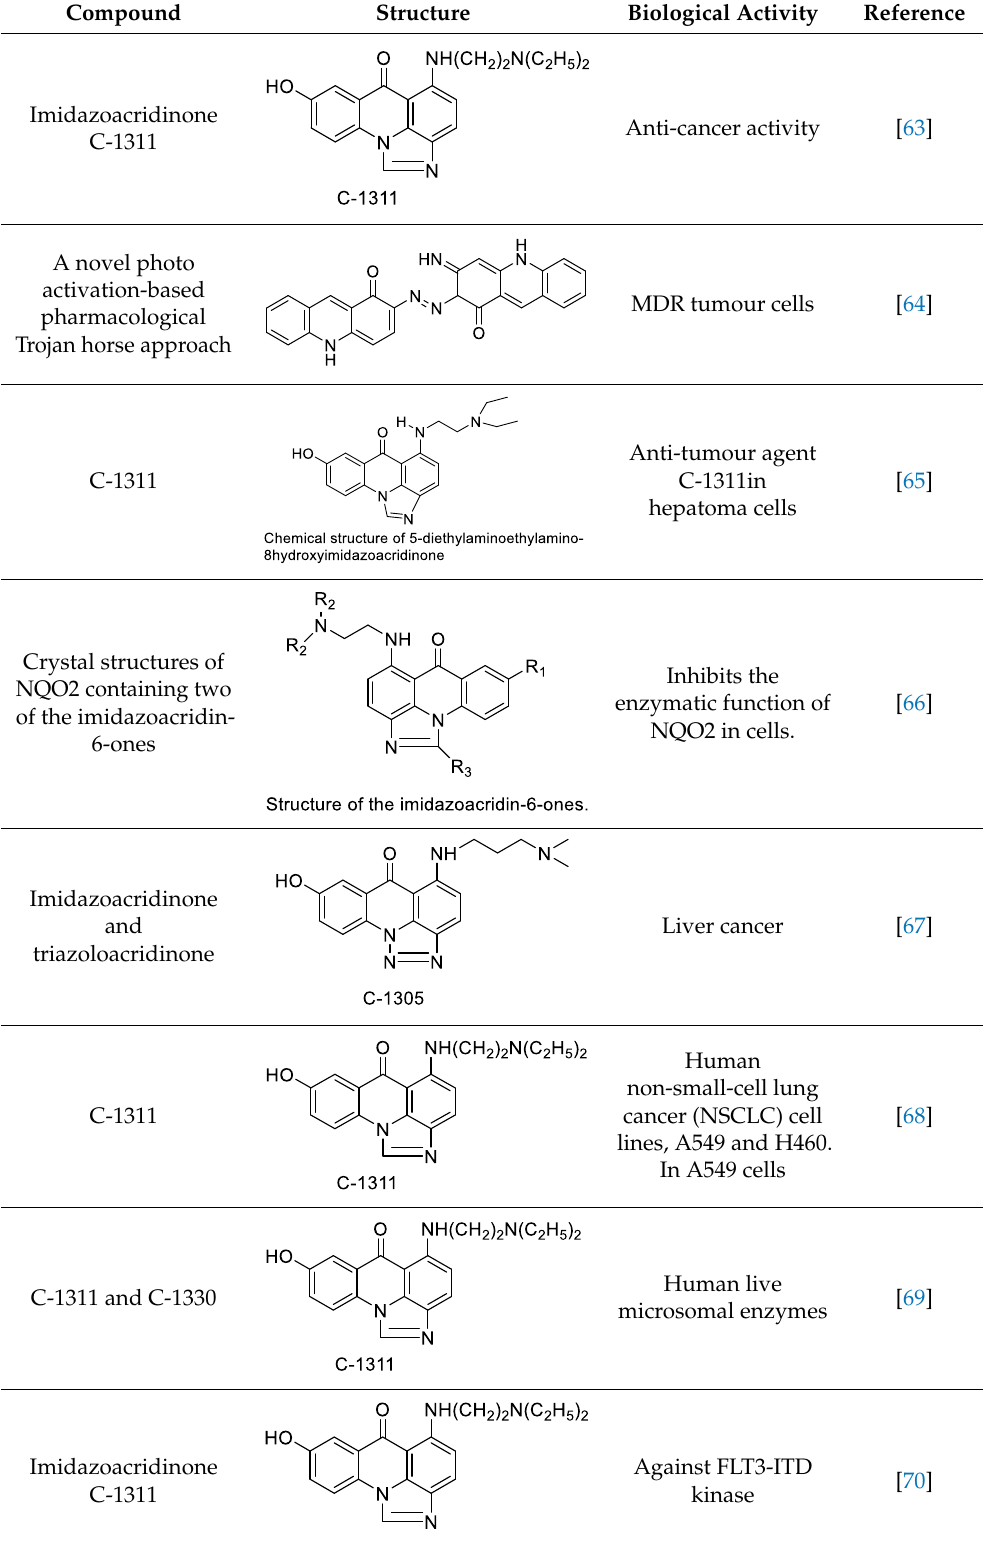
Table 9. Imidazoacridinone as an anti-tumour agent.